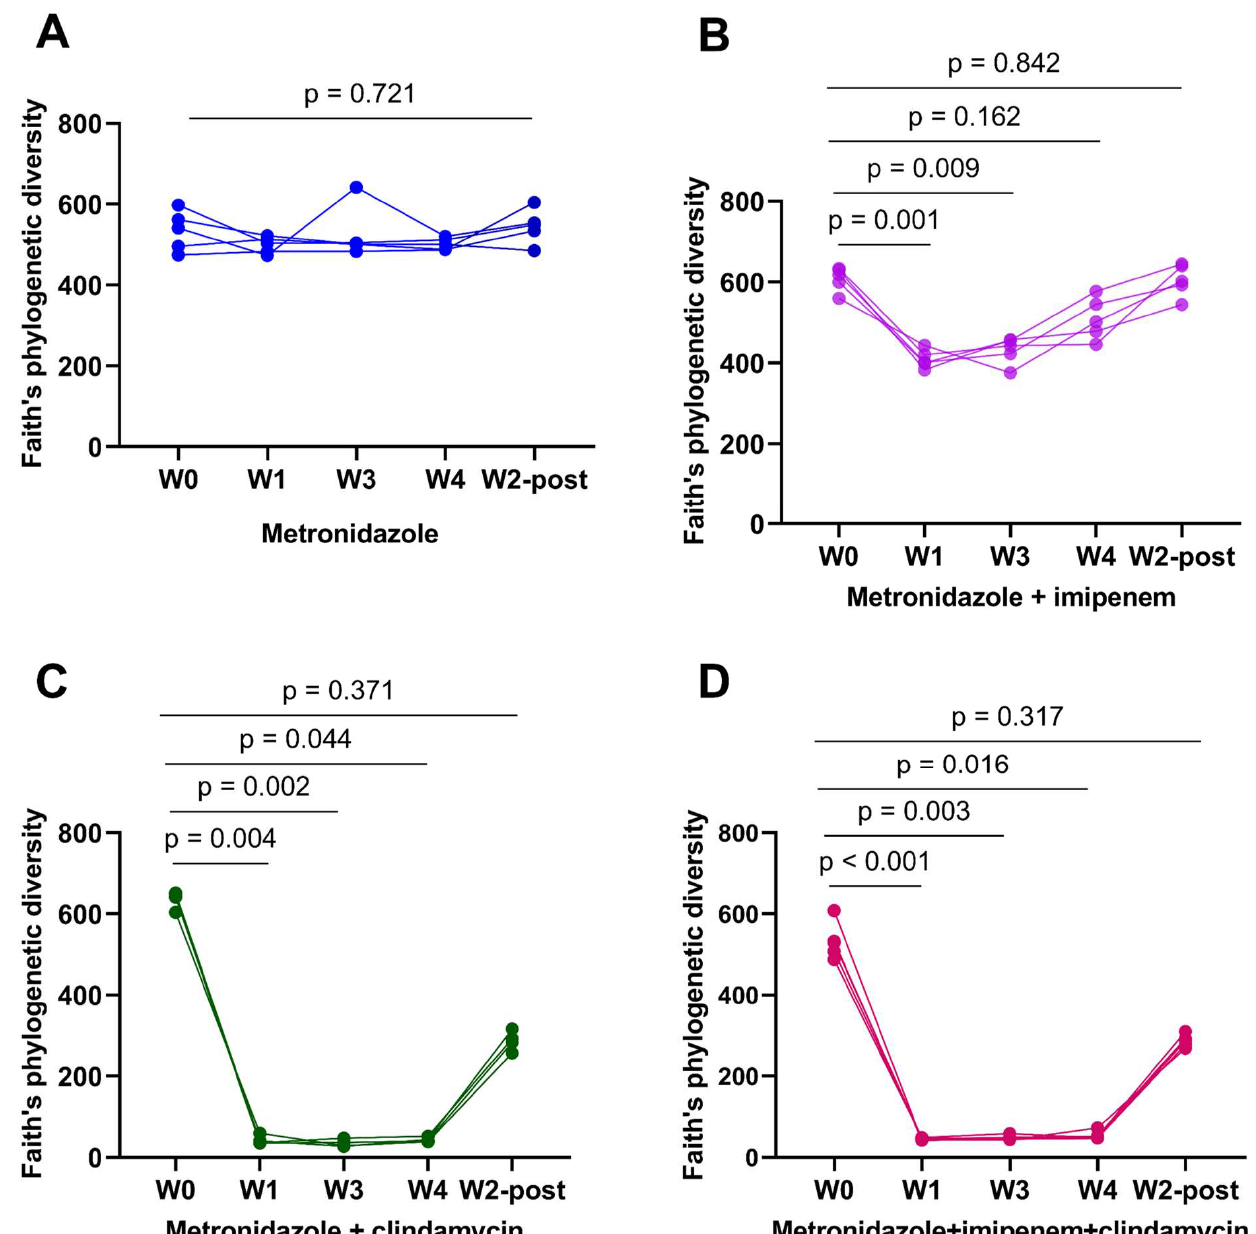
Figure 2. The addition of clindamycin rapidly reduces gut microbial diversity ( A – D ) alpha-diversity measured using Faiths’ phylogenetic index in metronidazole, metronidazole + imipenem, metronidazole + clindamycin, and metronidazole + imipenem + clindamycin-treated mice, respectively. p values for comparison between the baseline and the different time points are shown.